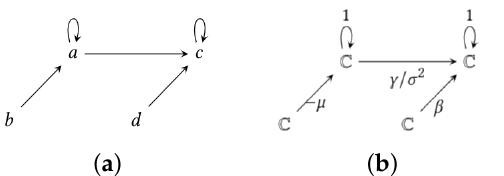
Figure 6. ( a ) Combinatorial architecture of a batch normalization layer. ( b ) Weight and activation architecture of a batch normalization layer. Observe that vertices b and d are bias vertices, and therefore the layer computes x (cid:55)→ x − µ (cid:55)→ ( x − µ )( γ / σ 2 ) + β , which is the definition of the batch norm operation.